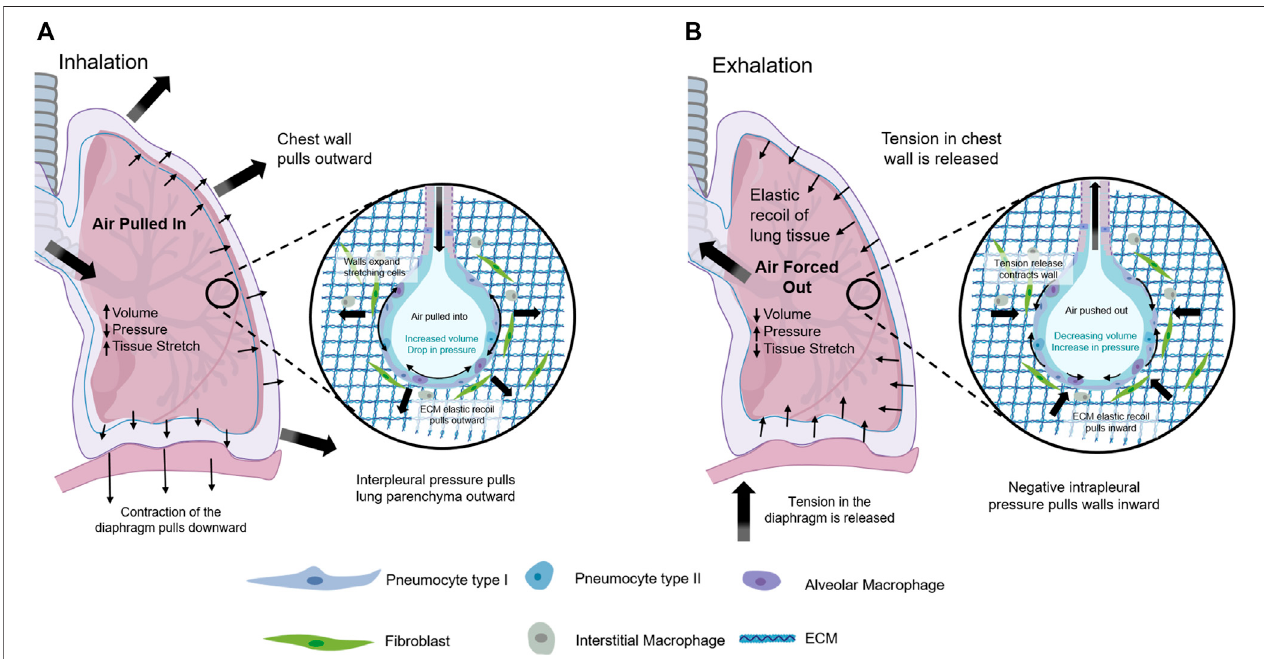
FIGURE 1 | Mechanical Forces within the lung. (A) Contraction of the diaphragm and muscles in chest wall during inhalation led to negative interpleural pressure thatenlargedlungtissue,stretchedthealveoli,andincreasedlungvolumedrivingairpulledin. (B) Relaxationofthediaphragmandmusclesinchestwallduringexpiration permitted for elastic retreat that decreased lung volume and air compression that drove air forced